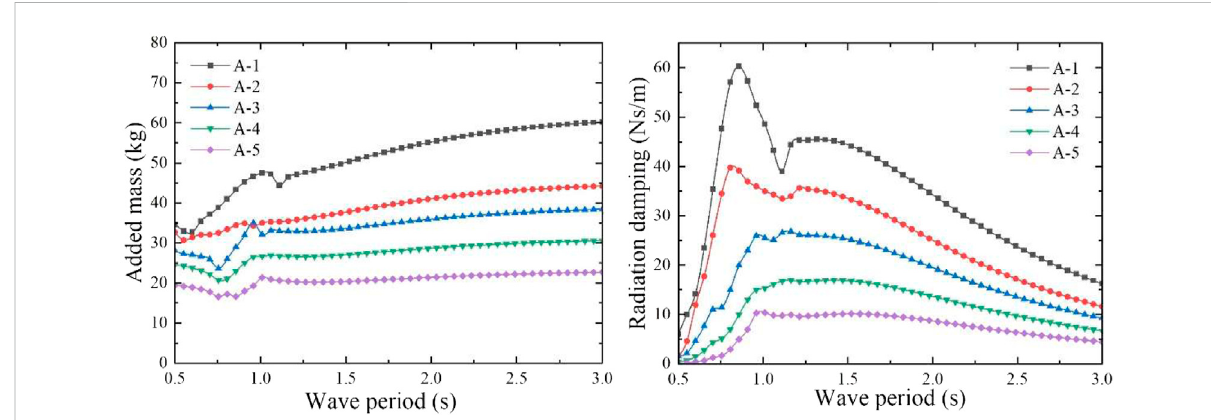
FIGURE 7 Heave added mass and radiation damping coef fi cient of the fi ve dual-chamber OWC models with the chambers of different geometric